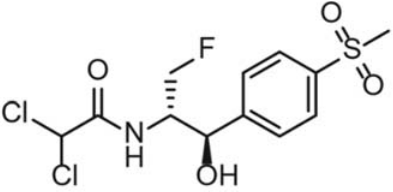
Figure 1. Chemical structure of florfenicol.